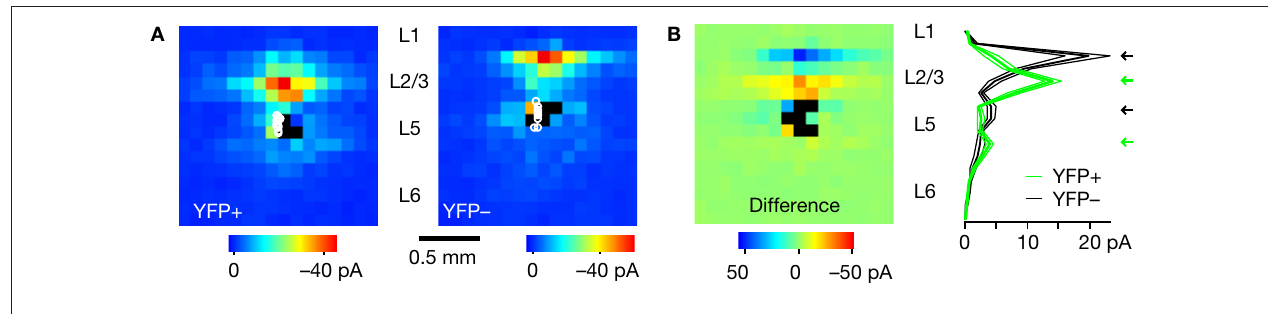
FIGURE 3 | Comparison of excitatory input topography for YFP-positive and YFP-negative neurons. Only neurons in upper layer 5 were included in the analysis. (A) Average synaptic input maps for YFP-positive ( n = 17 cells) and YFP-negative neurons ( n = 11 cells). (B) Difference map, calculated by subtracting the YFP-negative map from the YFP-positive map. Plot on